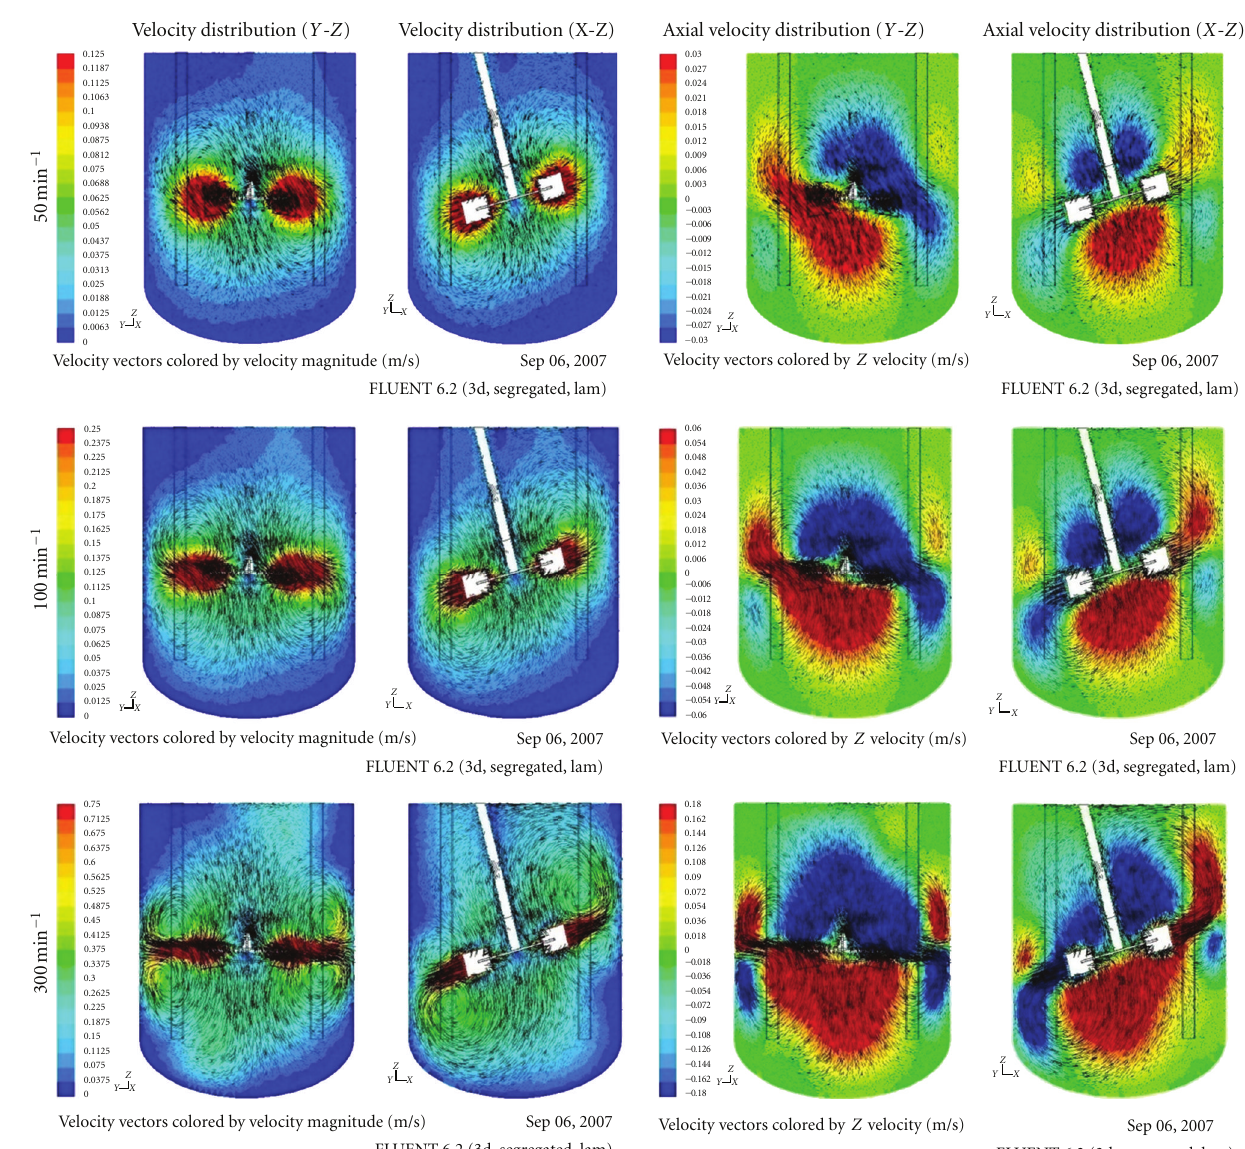
Figure 6: Three-dimensional flow velocity and axial velocity distribution (impeller inclined at 15 ◦ ). The rate vector was overlapped with each figure. The range of coloring was displayed in proportion to the rotational